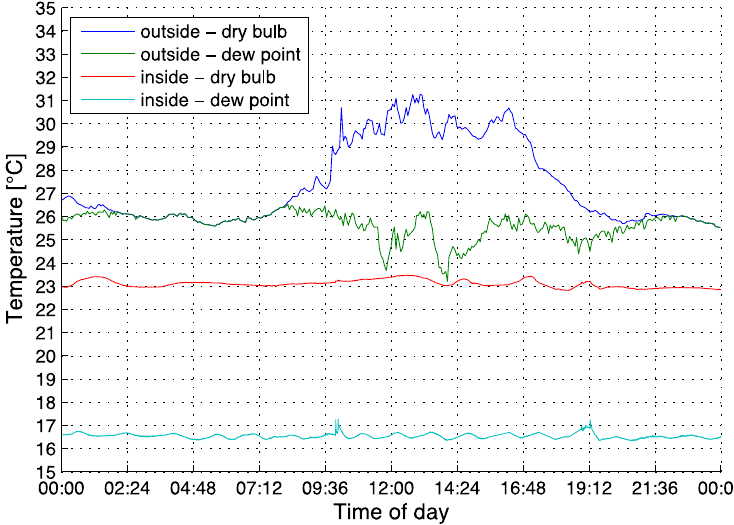
Figure 8. Outside and inside dry bulb and dew point temperature for one